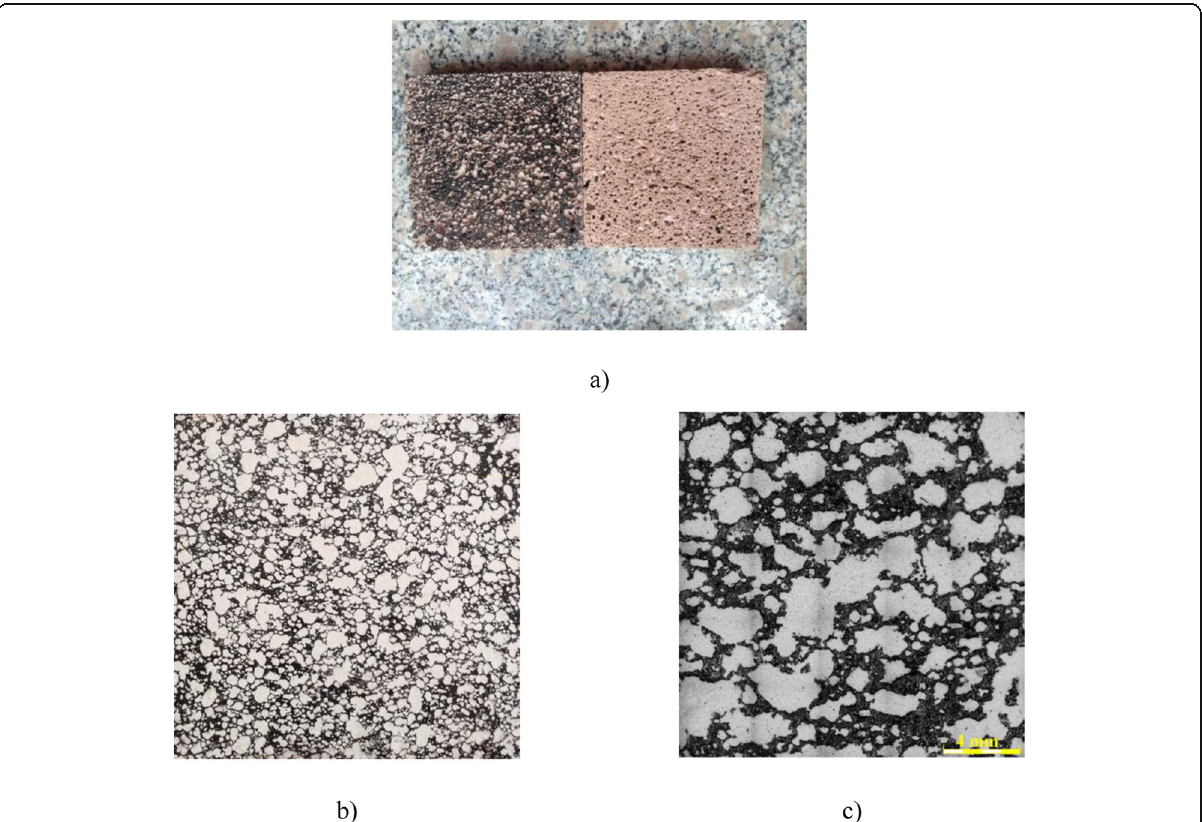
Fig. 1 Super depth of field microscope (SDFM) images for pore characterization of SCGAAC: a) black-painting slice vs. original slice; b) pore-filling slice; c) capture